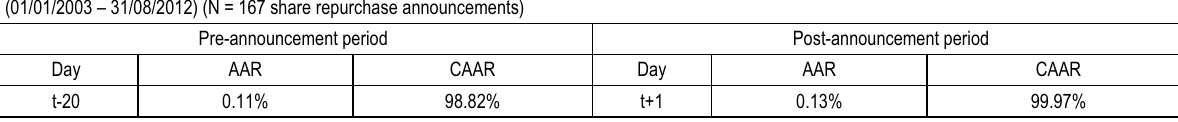
Table 5. Daily AAR and CAAR for the final